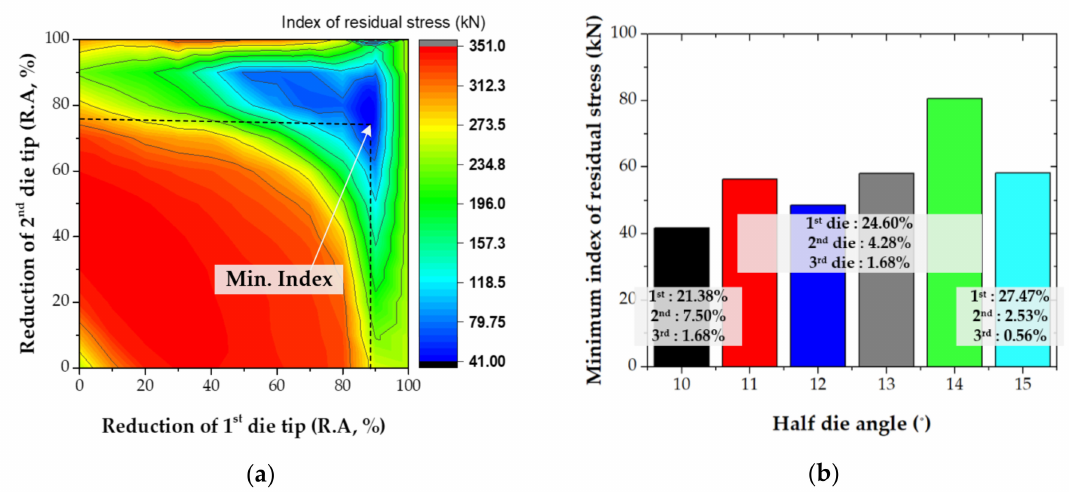
Figure 12. Result of machine learning (ML) according to the half die angle: ( a ) predicted result by DNN; ( b ) minimum